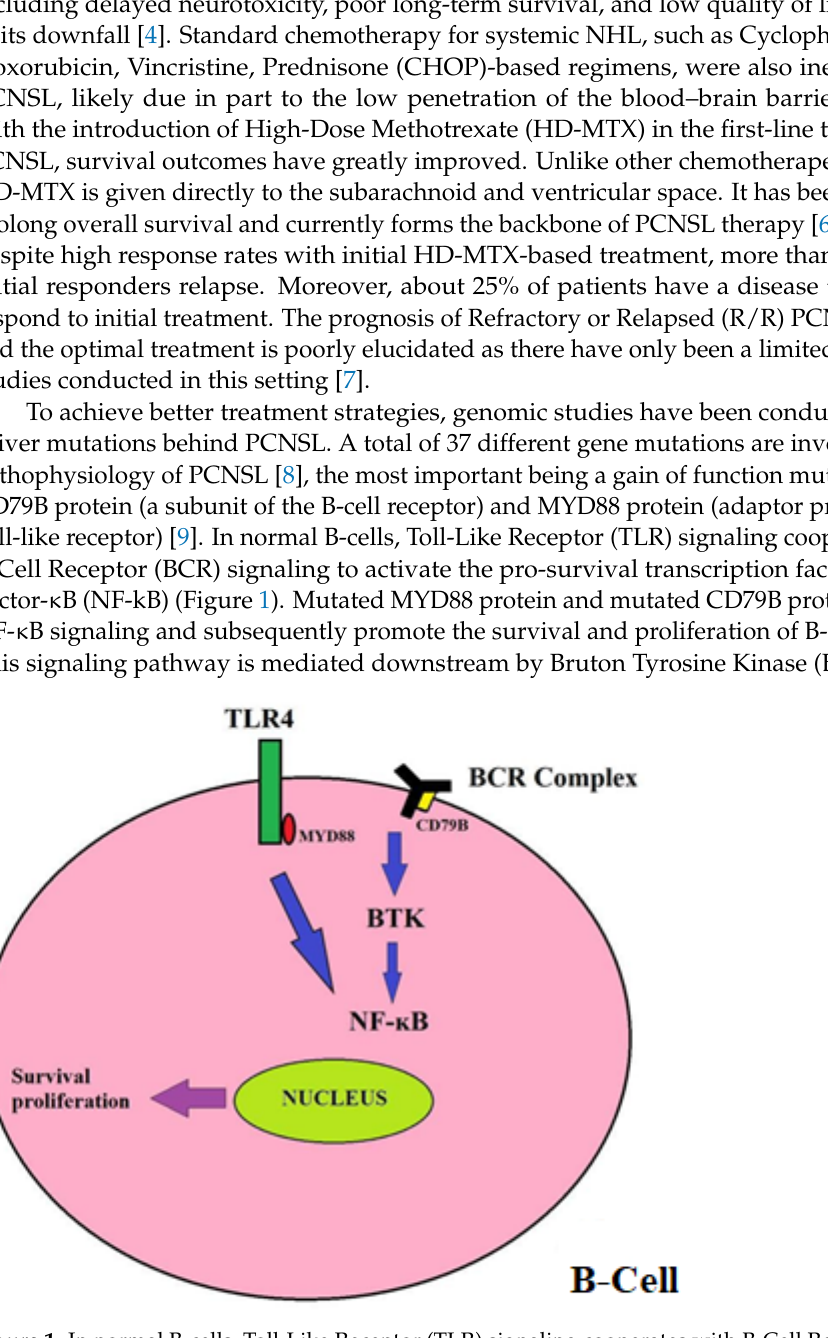
Figure 1. In normal B-cells, Toll-Like Receptor (TLR) signaling cooperates with B-Cell Receptor (BCR) signaling to activate pro-survival transcription factor, Nuclear Factor- κ B (NF-kB). Mutation in the CD79B protein (a subunit of the B-cell receptor) and MYD88 protein (adaptor protein of the Toll-like receptor) activates NF- κ B signaling and subsequently promotes the survival and proliferation of B-cells. Abbreviations: BCR, B-Cell Receptor; TLR4, Toll-Like Receptor 4; BTK, Bruton Tyrosine Kinase; NF- κ B, Nuclear Factor- κ B.